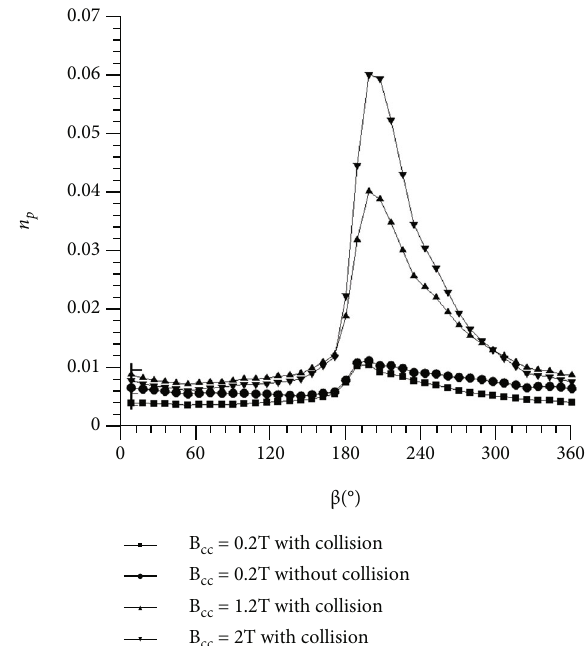
Figure 20: The change of primary electron density along the circumferential